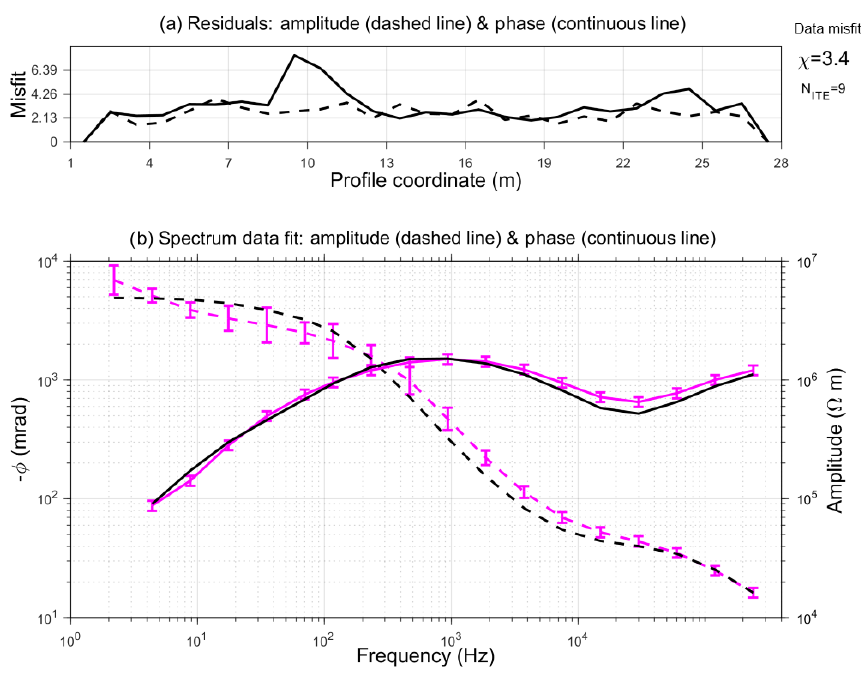
Figure 10. Data fit of the 2-D inversion of profile B-SCH. Panel (a) shows the misfit of amplitude (dashed line) and phase shift (solid line) over the profile. Panel (b) shows an example of measured (red) and inverted (black) spectra of amplitude (dashed lines) and phase (continuous lines), which belong to the dipole–dipole measurement starting from profile metre 16 ( a = 1m, n = 1) along the profile direction (see Fig. 7). The measured data are the same as in Fig. 4, with resistivity instead of impedance, and phase shift on a logarithmic scale. The total data misfit is χ = 3 . 4 after nine iterations. For each profile coordinate, the misfit of all data corresponding to this point was averaged to obtain the top panel (a) .